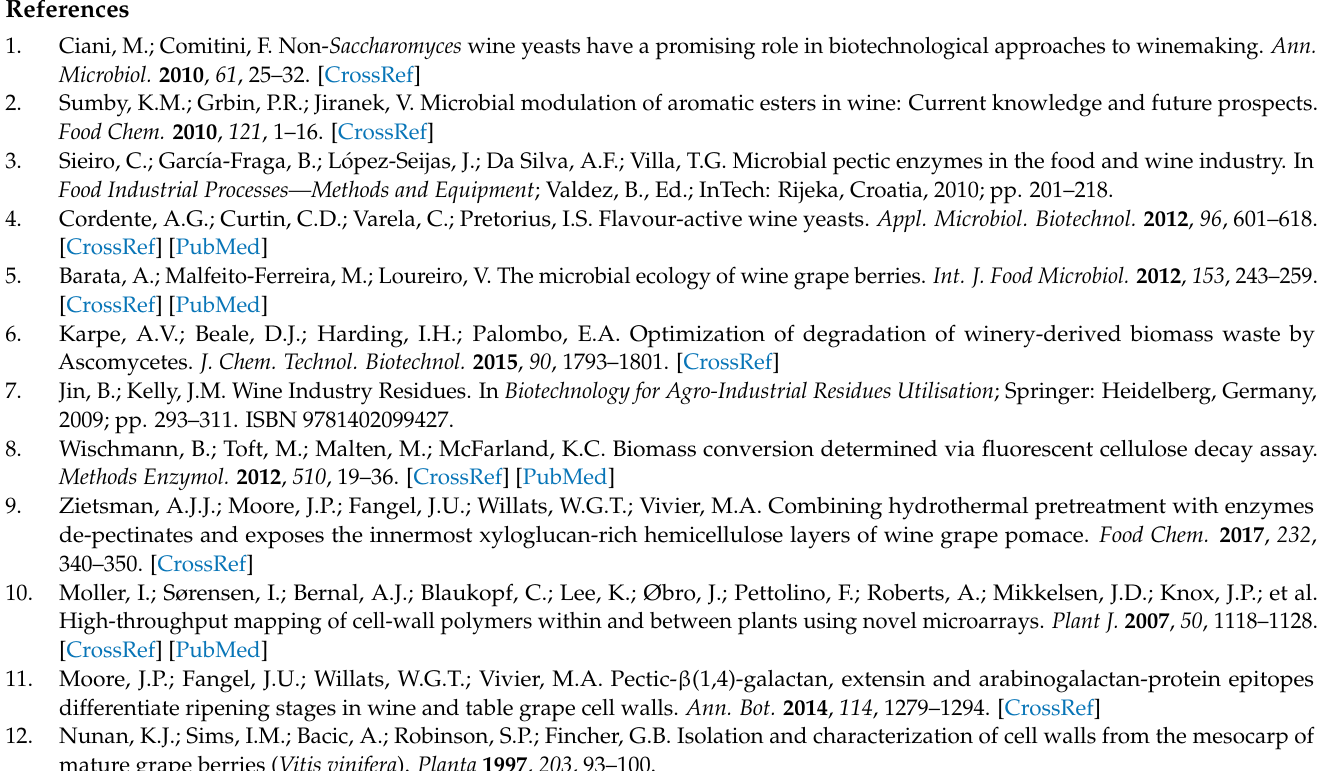
Figure S1: Proof of integration of the kan r and END1 integration cassettes into the VIN13 genome; Figure S2: PR7 END1 recombinant transformants identified with PCR; Figure S3: Reducing